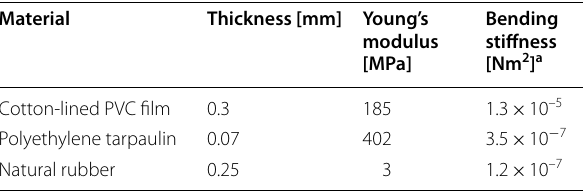
with different outer membranes of varying thicknesses and Young’s moduli were developed. The grippers each enclosed 60 sponges of height 30 mm, thickness 30 mm,